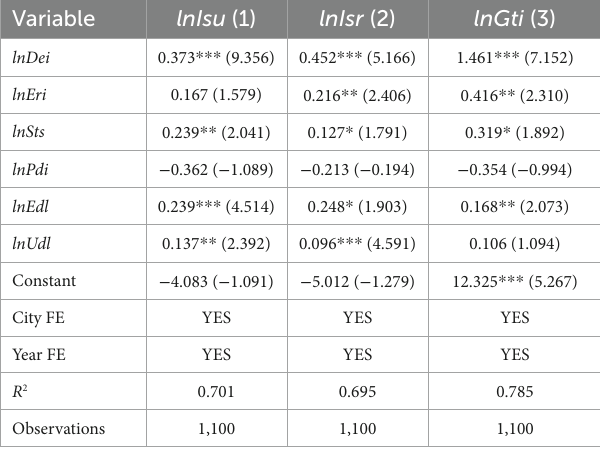
TABLE 4 Digital economy and mediating variables.